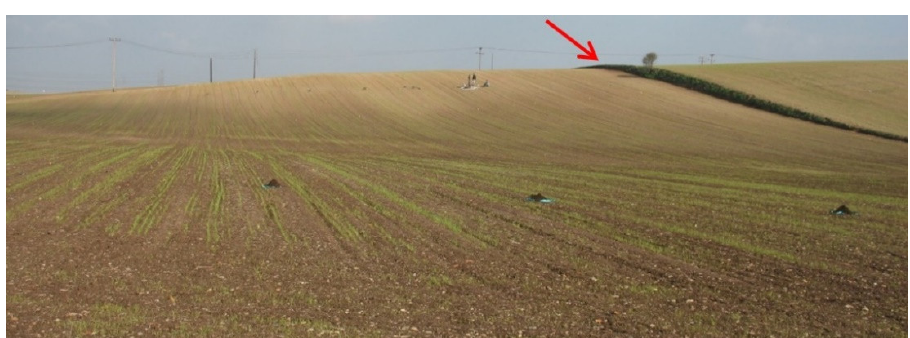
Figure 1. Side view of the experimental field.